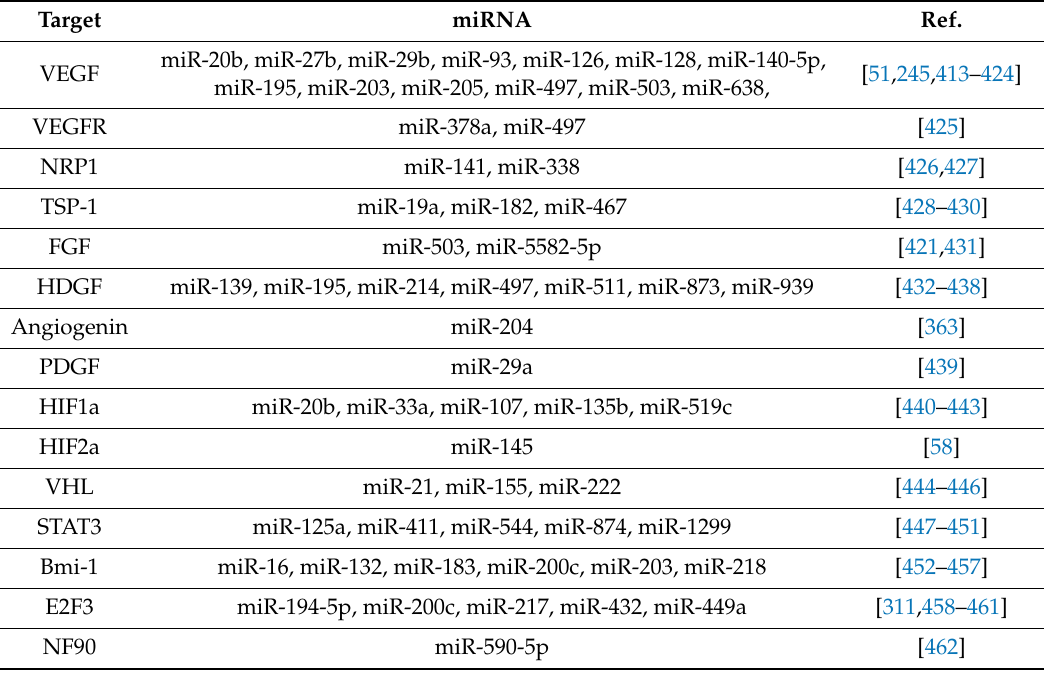
Table 7. The direct regulation of the angiogenesis pathway by miRNA. Target miRNA